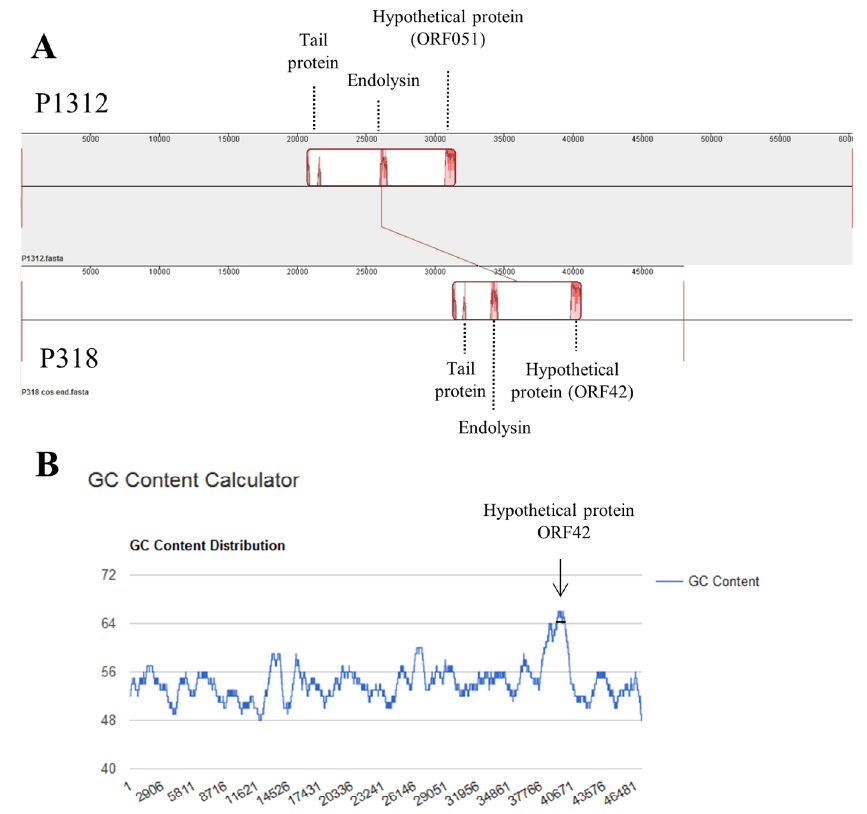
Figure 6. Genome comparison between bacteriophages P318 and P1312. ( A ) The similarity in nucleotide sequences of the two phages was analyzed by the Mauve alignment. The regions with similarity are boxed and the height of signal reflects the similarity level. ( B ) The G + C content is calculated along the P318 genome with a window size of 1000 base pairs by the method provided in the website https: // www.biologicscorp.com / tools / GCContent /